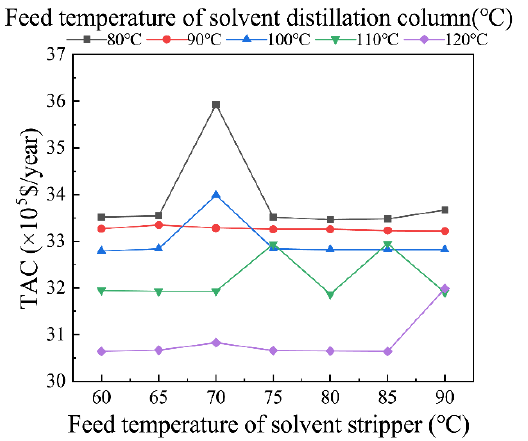
Figure 8. Effect of feed temperature of solvent stripper and solvent distillation columns on total annual cost of heat integration process.